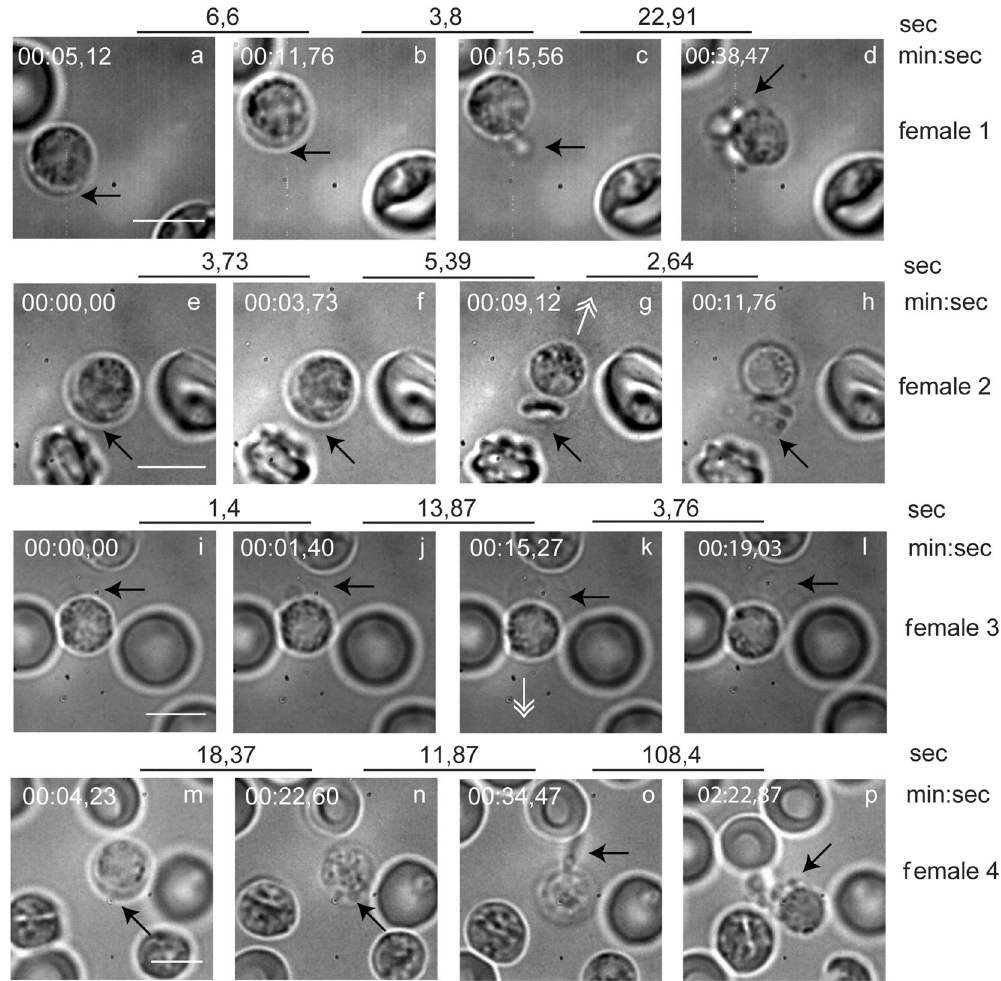
Figure 1. Snapshots from four movies of female gamete egress. Representative snapshots chosen to illustrate the stages of egress. Upper broken lines represent time in sec between each frame of the movies in real time. The time of each frame from the start of the movies is indicated above the snapshots (min:sec). For technical reasons this does not correspond with the time from the start of the experiment (activation). ( a – d ) Female 1. ( a ) An infected RBC in the initial phase of swelling. The parasite occupies most of the volume of the RBC. ( b ) The RBCM is more extended. ( c ) The PVM vesicles are extruded through a single pore. ( d ) Egress is complete. Vesiculated PVM and RBCM are localized in proximity to the gamete. ( e – h ) Female 2. ( e , f ) The PVM is already vesiculated inside the RBCM. ( g ) The RBCM is extended and the gamete slides out of the host membrane. ( h ) Egress is complete with vesicles next to the gamete. ( i–l ) Female 3. ( i ) The RBCM is largely extended. ( j ) PVM is ruptured and vesiculated. ( k ) The gamete slides out of the extended RBCM. ( l ) egress is complete, the RBCM is vesiculated. ( m – p ) Female 4. ( m ) RBC is swollen. ( n ) PVM vesicles are seen inside the RBCM towards the viewer. ( o ) Expulsion of PVM vesicles through a single pore. ( p ) Egress is complete. Black arrows indicate the area of interest in each snapshot, and white double arrows direction of gamete expulsion in ( g ) and ( k ). Scale bar, 5 μ m. See also Supplementary Information Videos